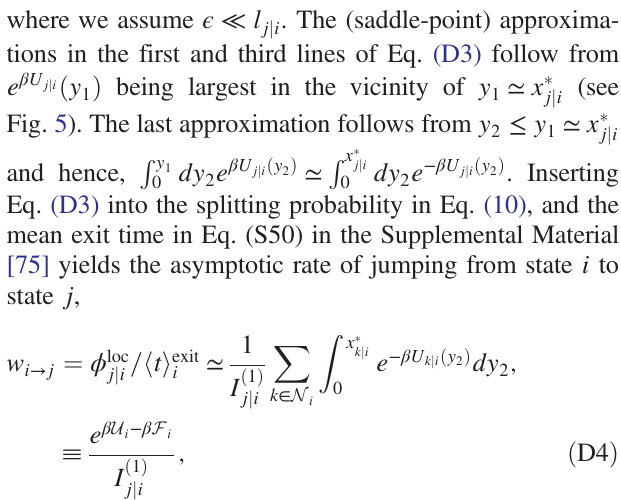
FIG. 12. One directed cycle C ¼ i C 1 → i C 2 → ; … ; → i C ν → i C ν ¼ i C 1 (see thick red arrow lines) is highlighted which encloses þ 1 ν ¼ j C j ¼ 6 nodes within a total set of Ω ¼ 9